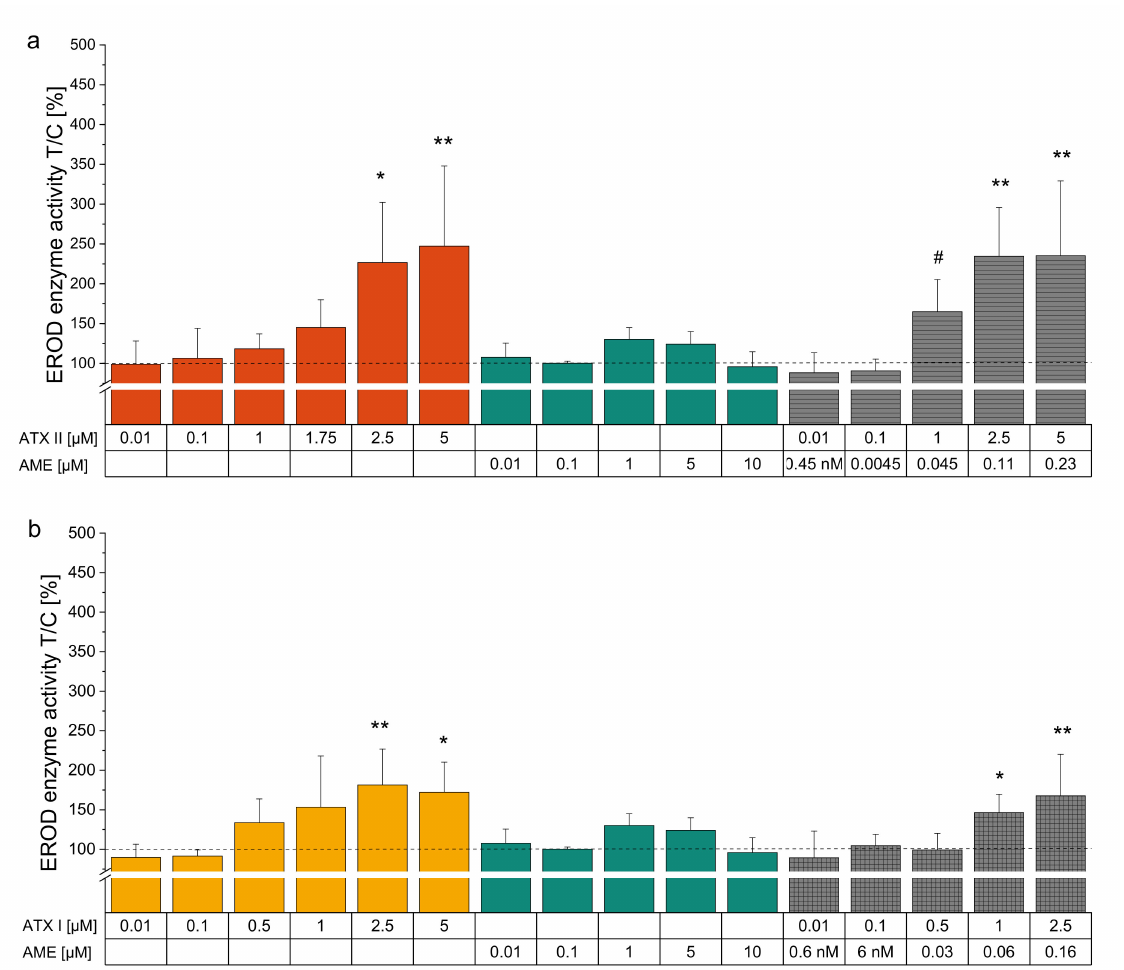
Figure 4. EROD assay of binary mixtures of ATX-II or ATX-I with AME in accordance to their respective ratios within the extract. Bar diagrams show EROD enzyme activity measurements (pmol resorufin / mg protein*min) presented as means + SD related to solvent control (1% DMSO) of at least 3 individual experiments. ( a ) ATX-II and AME binary combination at a ratio 22:1. ( b ) ATX-I and AME binary combination at a ratio 16:1. Significant di ff erences between combinatory e ff ects and ATX-I were calculated applying Student’s t -test and are indicated as “#” ( p < 0.05). “*” highlights significant di ff erences compared to the NOEL calculated via one-way ANOVA followed by Bonferroni post-hoc testing at p < 0.05 and “**” at p < 0.01. n = 3–5 individual